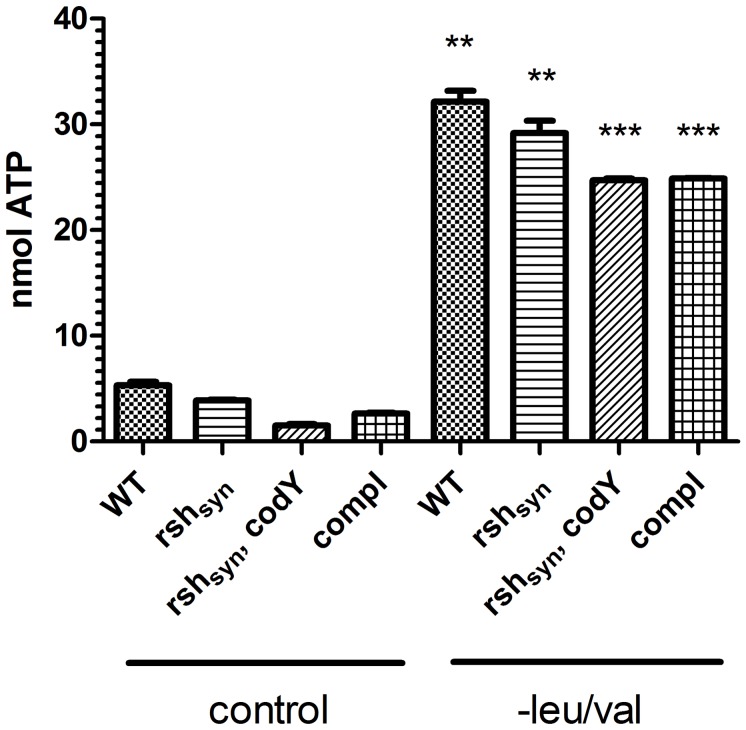
Quantitative analysis of the intracellular ATP concentrations.The intracellular ATP pools of strain HG001, the corresponding rshSyn mutant, the rshSyn, codY double mutant and the complemented rshSyn mutant (compl) were determined by luciferase activity. The bacteria were grown in CDM to exponential growth phase (OD600 = 0.5) followed by further incubation in medium with (control) or without (−) leu/val for 30 minutes. The levels of significance to the corresponding control (with leu/val) were determined by the two-tailed Student t test (p<0.05).